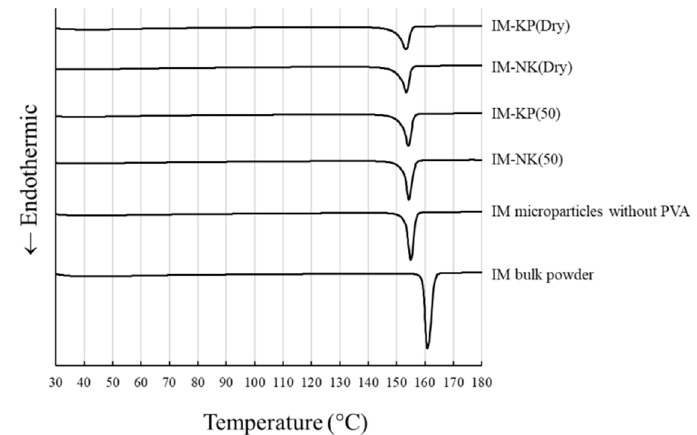
Figure 6. DSC Thermograms of the IM Microparticles.